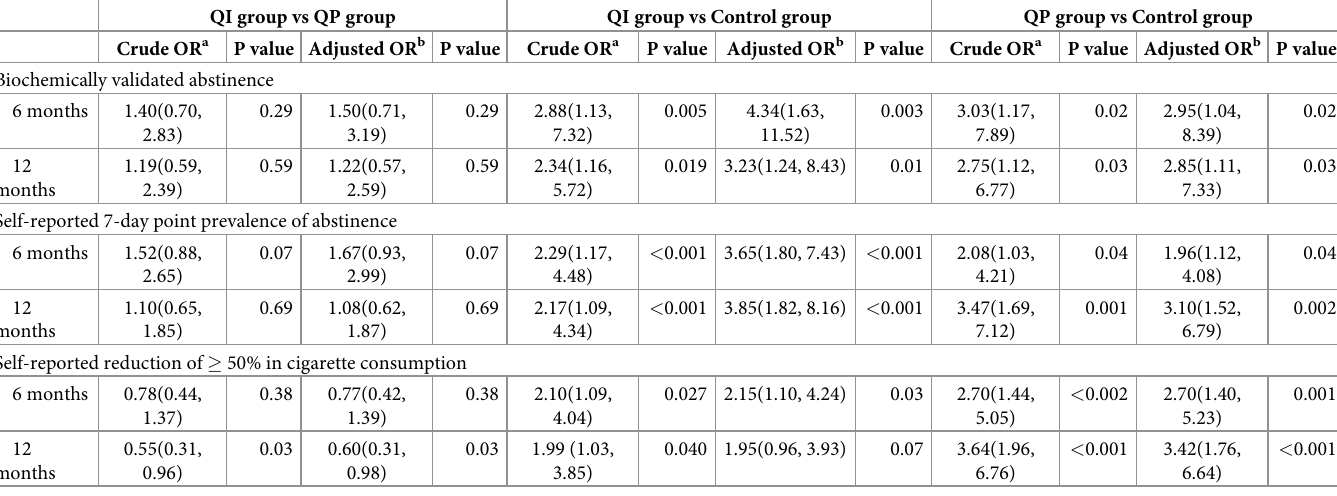
Table 4. Logistic regression for validated abstinence, self-report abstinence, and reduction of cigarette consumption among the QI group (n = 174), QP group (n = 174) and control group (n = 174) in the propensity-score matched sample. QI group vs QP group